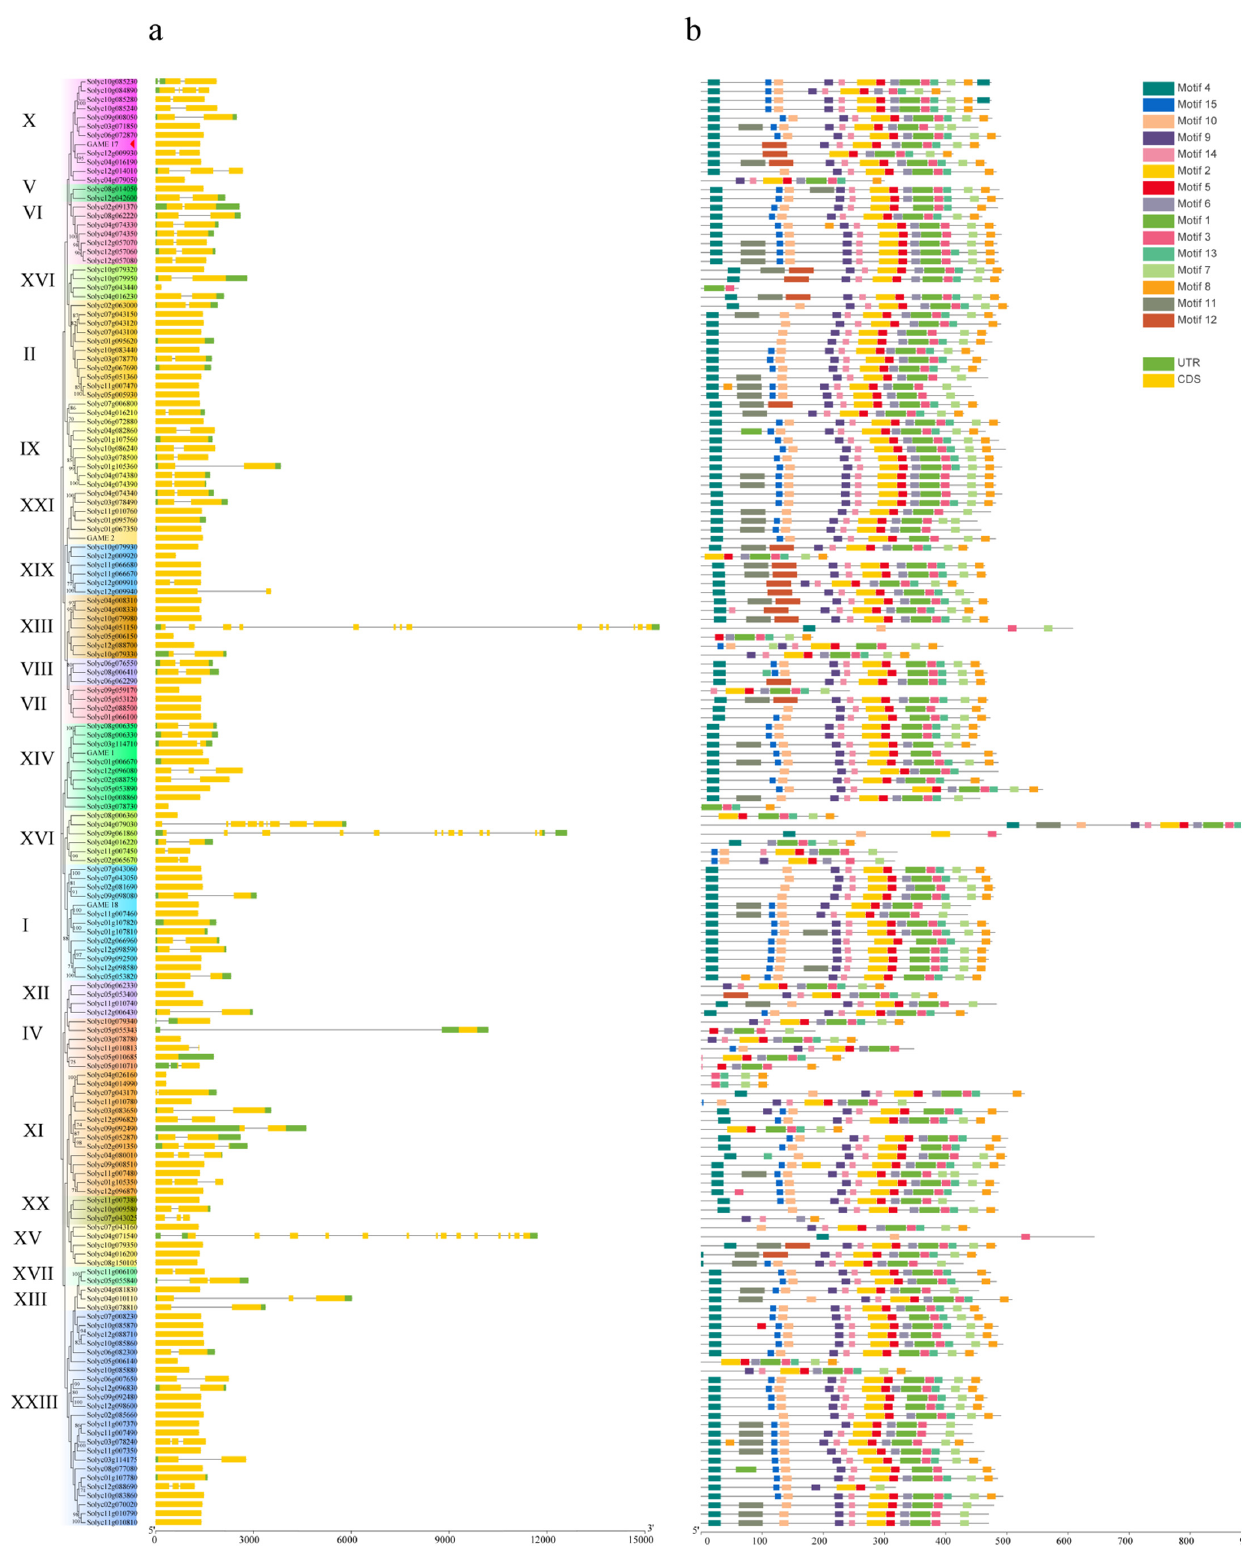
Figure 3. Schematic diagram of conserved motifs and gene structures of SlUGT family members in S. lycopersicum . ( a ) The intron and exon structures of the SlUGT genes were obtained by Perl scripts and visualized by GSDS software. ( b ) Motif analysis was conducted using MEME online